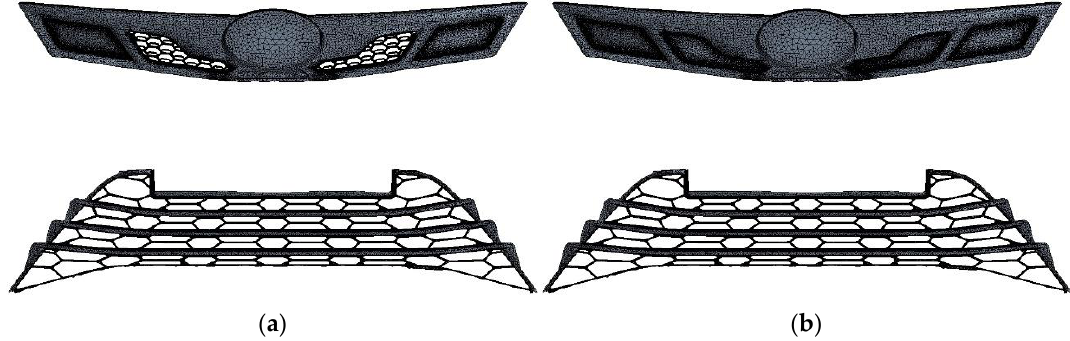
Figure 8. Closure schemes of the upper grille: ( a ) scheme 1; ( b ) scheme 2.